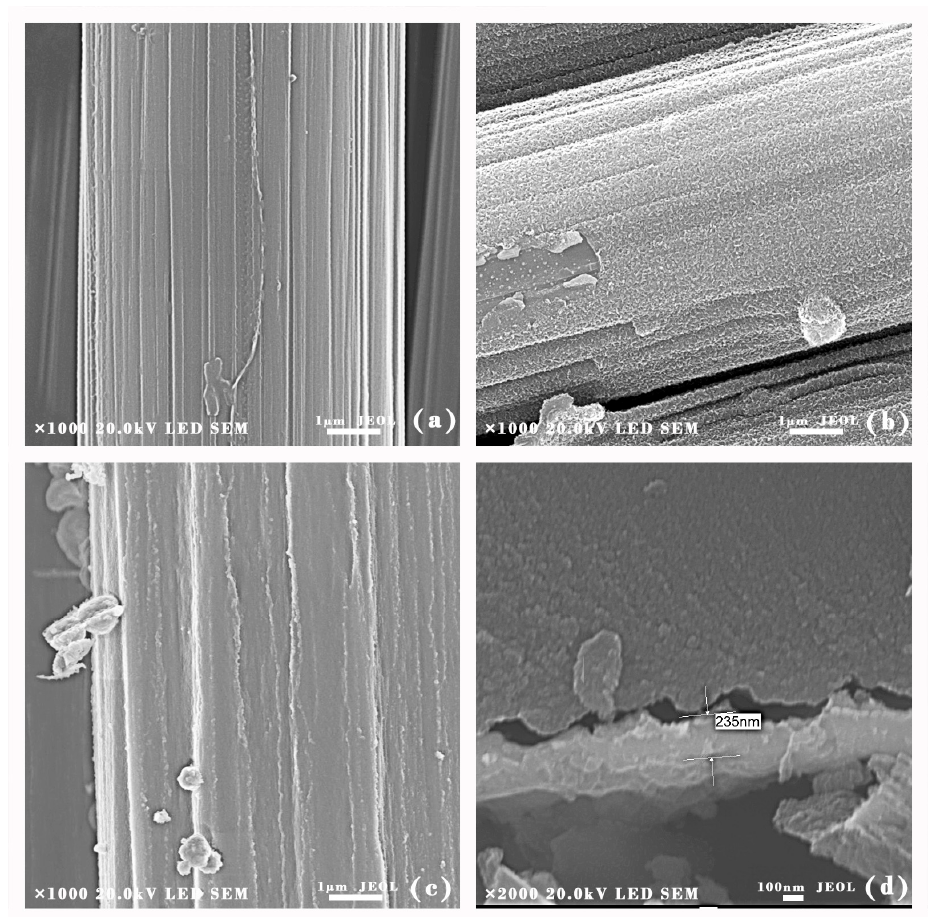
Figure 2. Scanning Electron Microscope (SEM) images of ( a ) uncoated carbon fibers (CF); ( b ) SiO 2 coated CF; ( c ) SiC/SiO 2 coated CF; and, ( d ) cross-section of coated CF.